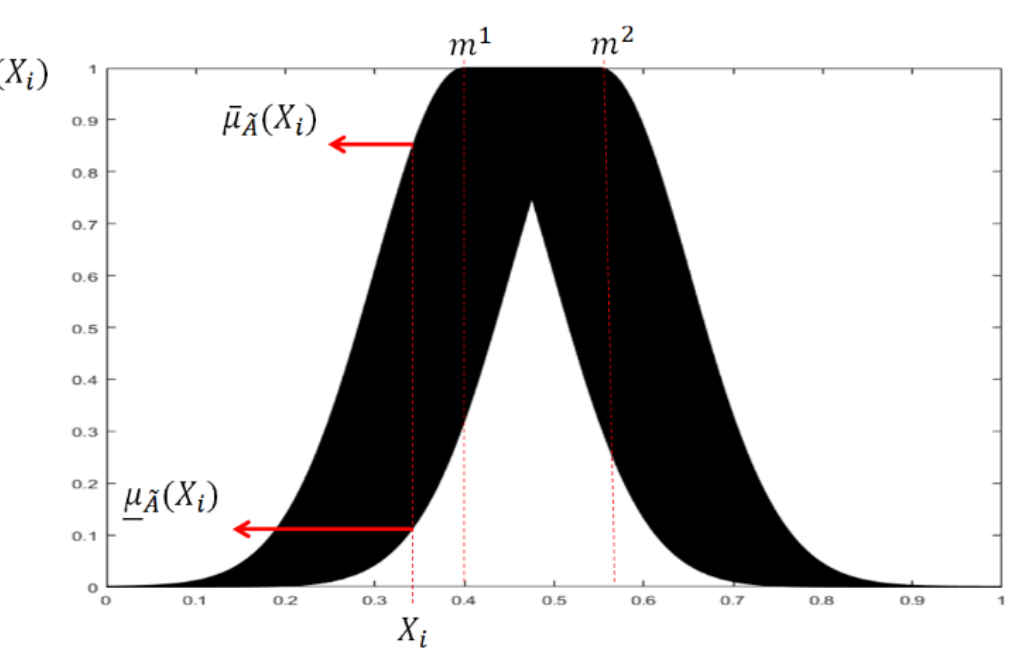
Figure 8. Interval type-2 fuzzy set.